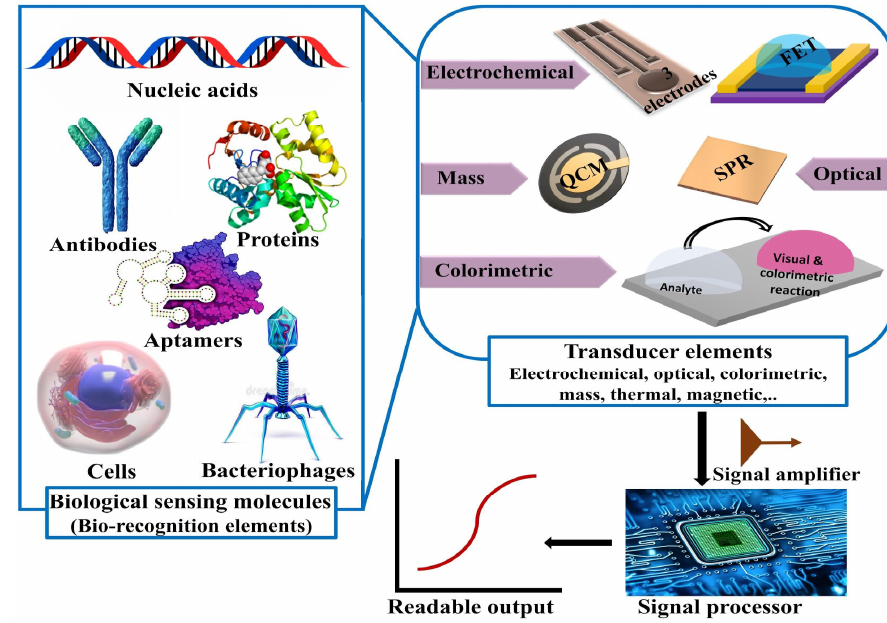
Figure 8. Main components of biosensors.